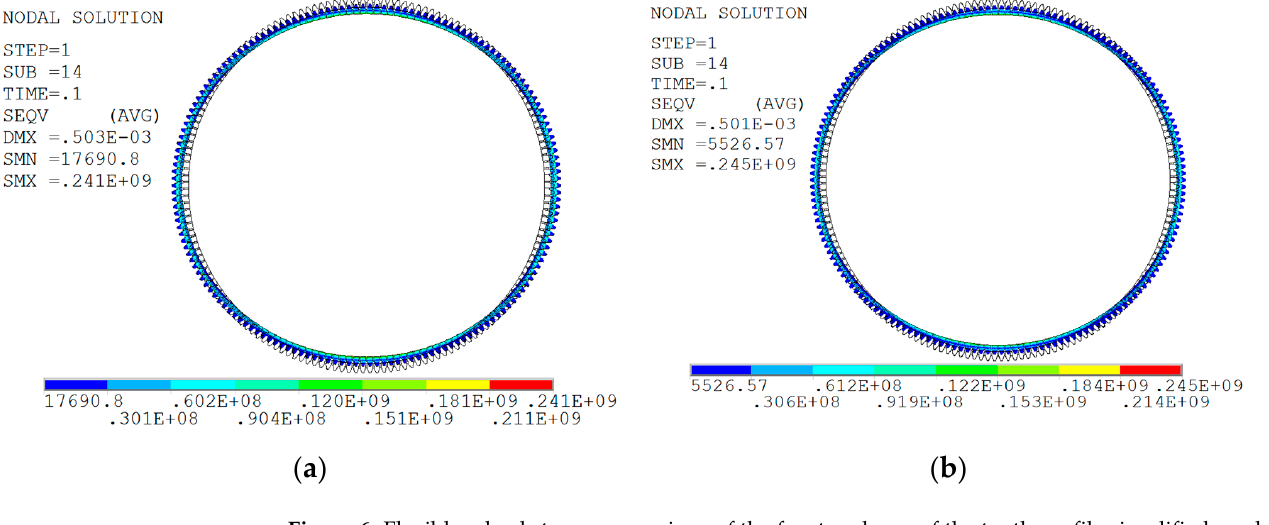
Figure 6. Flexible wheel stress comparison of the front and rear of the tooth profile simplified mesh. ( a ) Stress nephogram before tooth profile mesh simplification. ( b ) Stress nephogram after tooth profile mesh simplification.